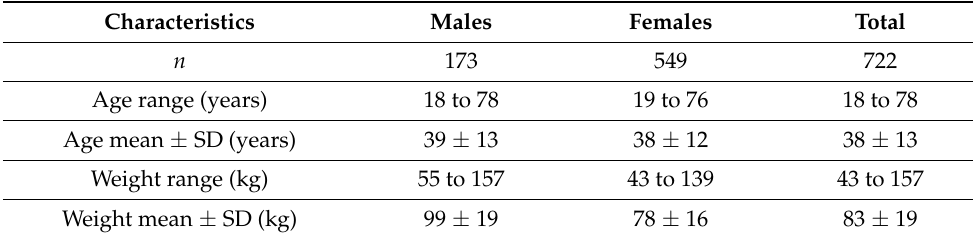
Table 2. Characteristics of the study